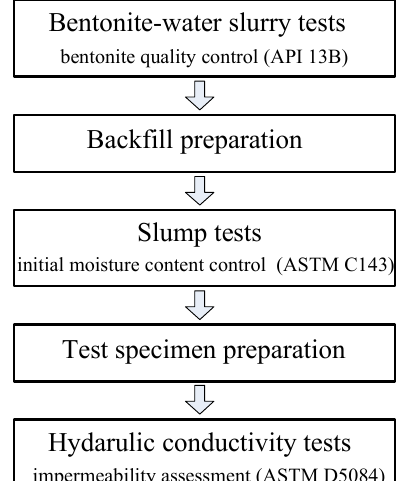
Figure 1. Scheme for flexible-wall hydraulic conductivity tests.